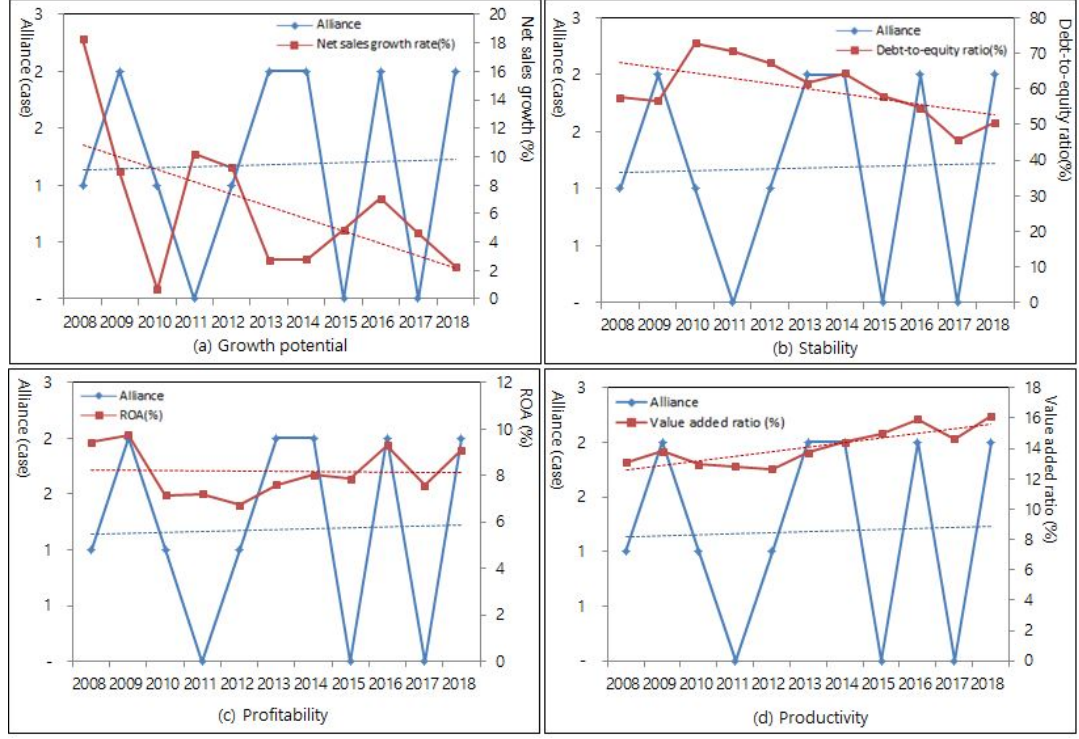
Figure 5. Analysis of Ottogi’s financial ratio.